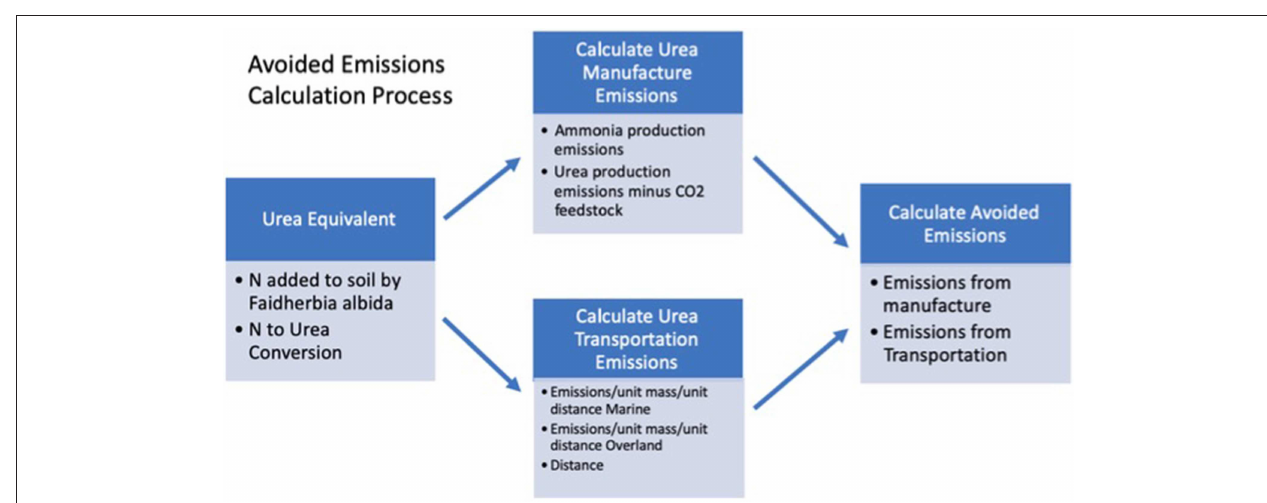
FIGURE 2 | Faidherbia albida avoided emissions calculation